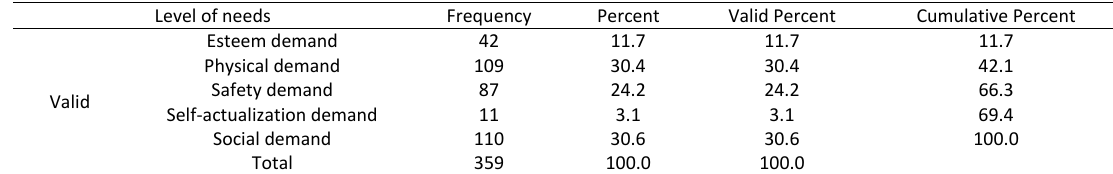
Table 3: The frequency and percentage of smart sustainable city indicators in each level of the hierarchy of needs